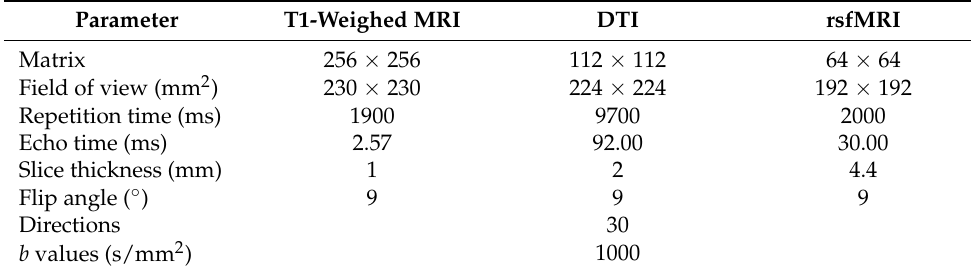
Table 1. Magnetic resonance imaging (MRI) data acquisition.